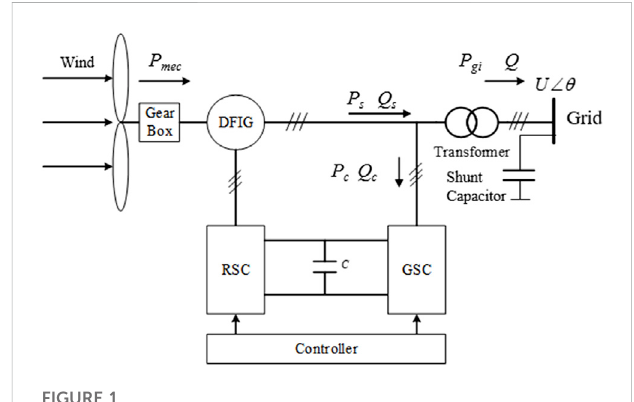
FIGURE 1 Con fi guration of doubly-fed induction